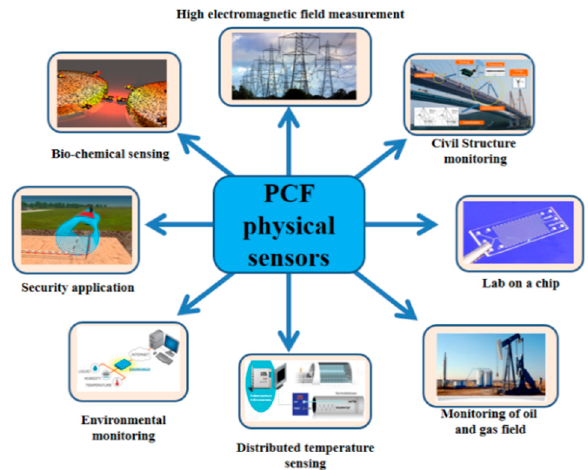
Figure 1. Applications of photonic crystal fiber (PCF) physical sensors.